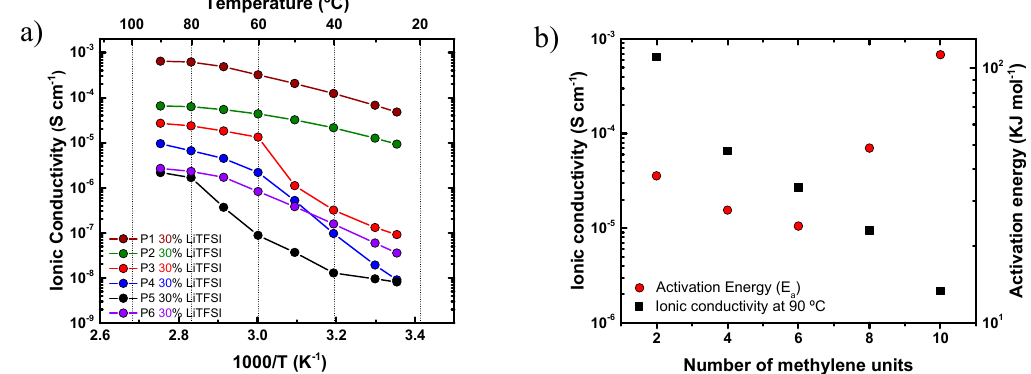
Figure 4. ( a ) Ionic conductivity of the polyethers with 30 wt % LiTFSI. ( b ) Ionic conductivity of the polyethers with 30 wt % LiTFSI at 90 °C and activation energy ( E a ) calculated in the molten state for the SPEs.